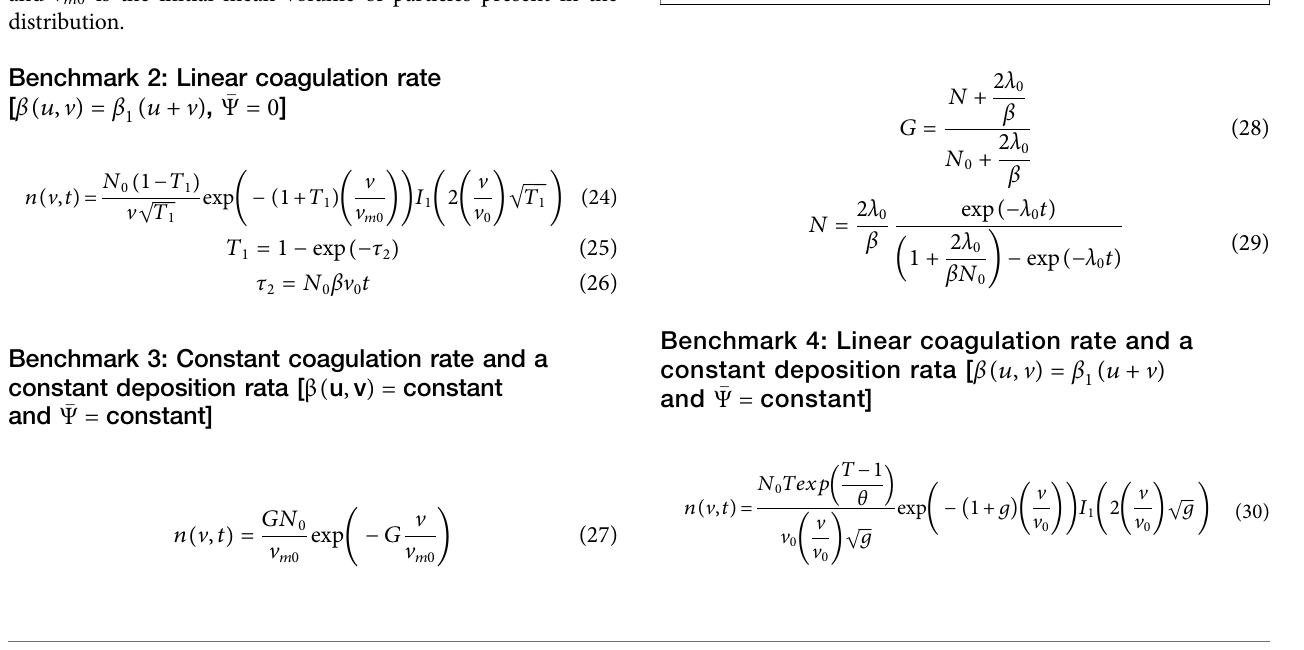
FIGURE 1 | Flow chart of the